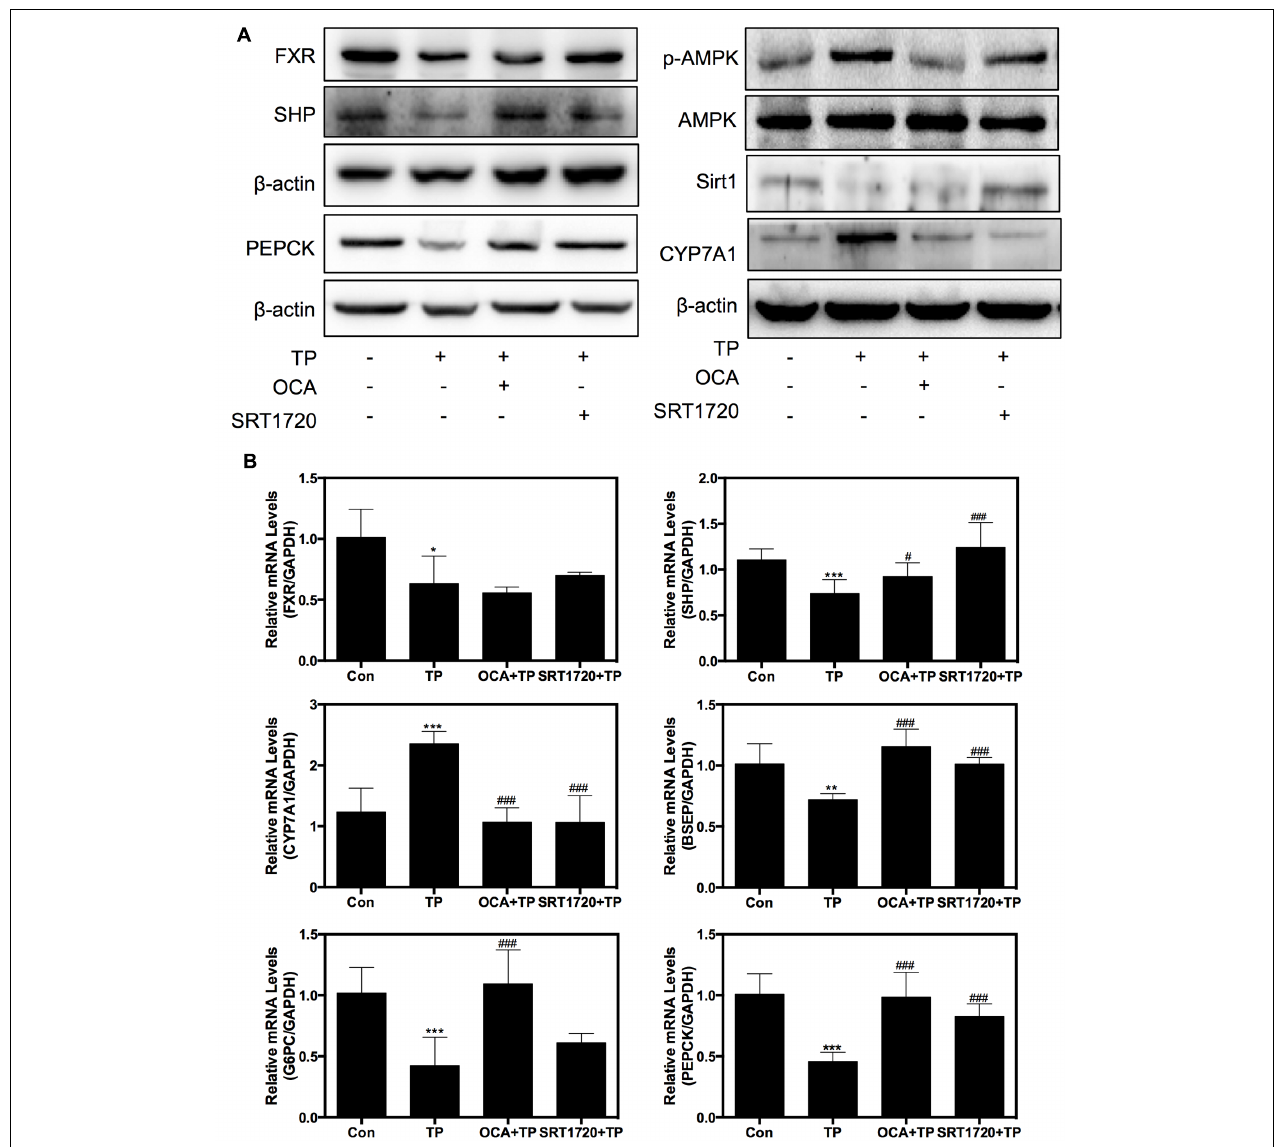
FIGURE 6 | Regulation of the expression of proteins and genes involved in TP-induced hepatotoxicity by SRT1720. Female Wistar rats were treated as previously described in the Section “Materials and Methods”. (A) Representative immunoblots against p-AMPK, T-AMPK, Sirt1, FXR, and FXR-targets in the liver lysates are shown and normalized to β -actin as a loading control. (B) The relative mRNA levels of the relevant genes were determined using real-time RT-PCR and normalized to GAPDH as an internal control. Statistical significance relative to vehicle control, ∗ p < 0.05, ∗∗ p < 0.01, ∗∗∗ p < 0.001; and statistical significance relative to the TP treated group, # p < 0.05, ## p < 0.01, ### p <